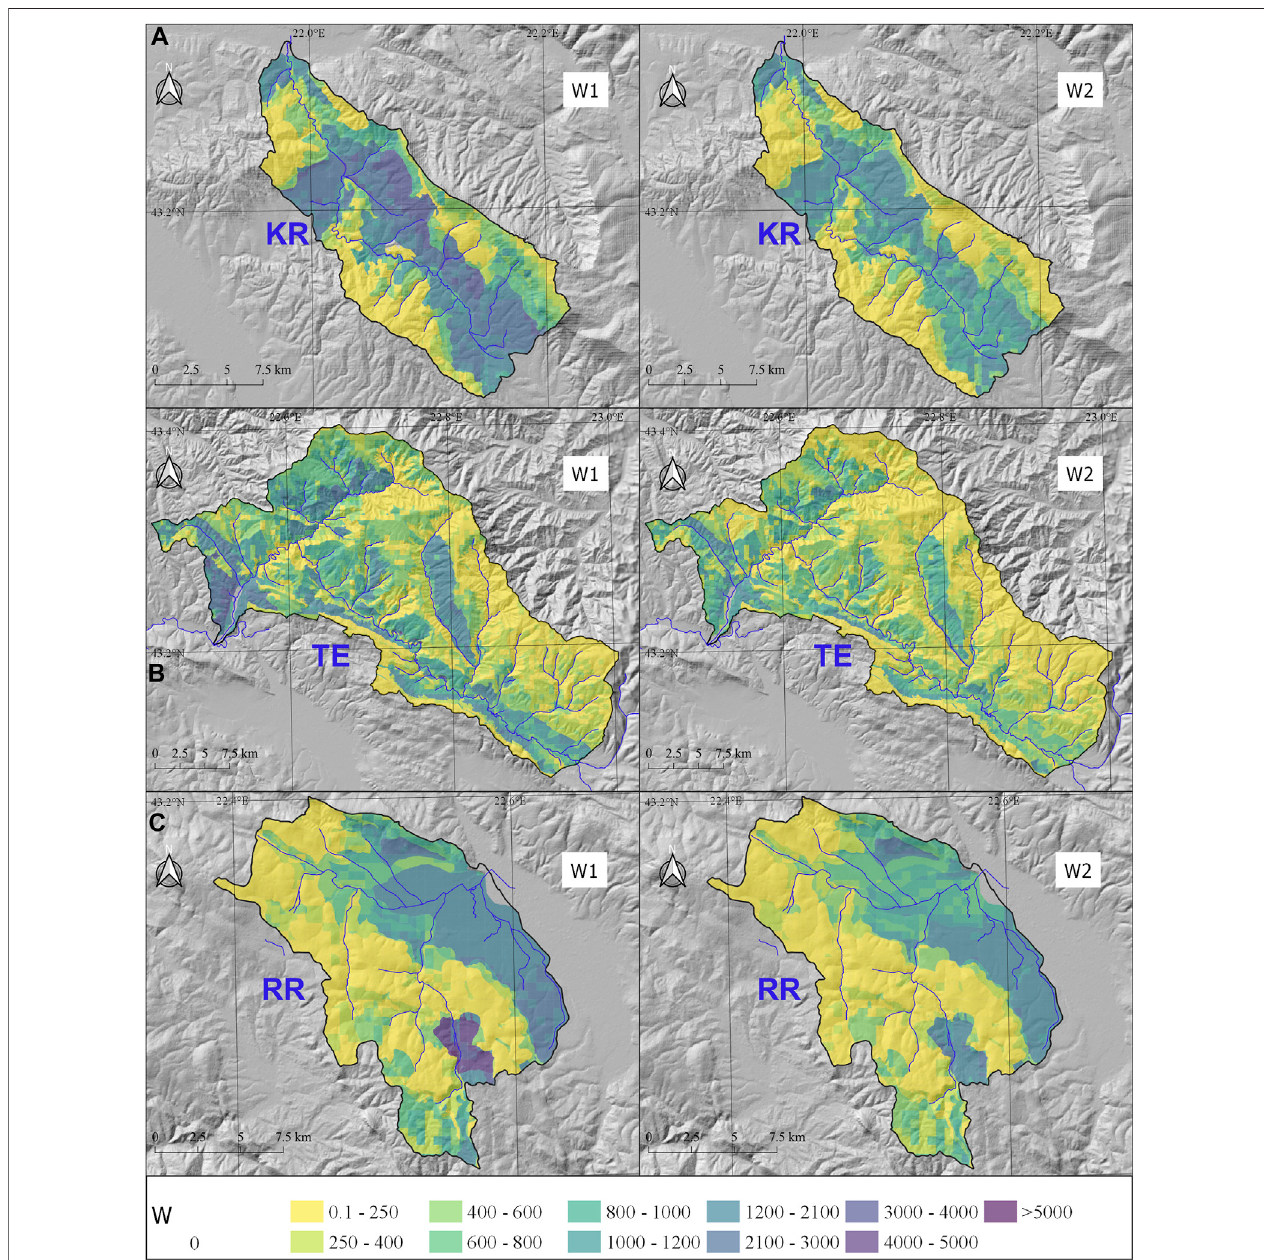
FIGURE 6 | Speci fi c annual gross erosion (Ws, m 3 /km 2 /yr) 1971 (W1) and 2010 (W2) for characteristic watersheds according to the typological classi fi cation. (A) Kutinska river (KR) – Population type (D1), (B) Tem š tica (TE) – Demographic-agrarian type of progressive settlements (D3) and (C) Rasni č ka river (RR) – Demographic- agrarian type of stagnant and regressive settlements